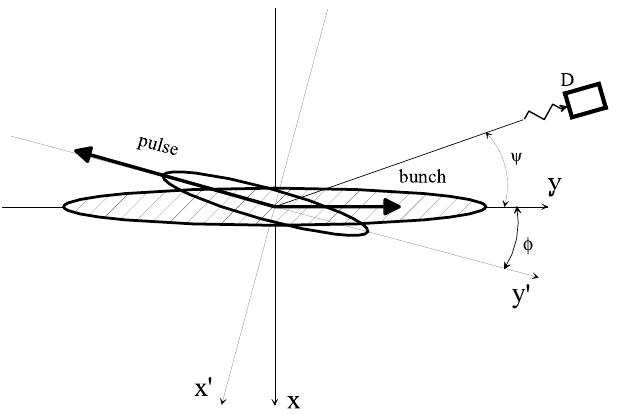
FIG. 1. The electron and photon coordinate frames: z coin- cides with z 0 and directed upward from the (cid:2) x; y (cid:3) plane. The electron bunch is dashed, D is a detector of x